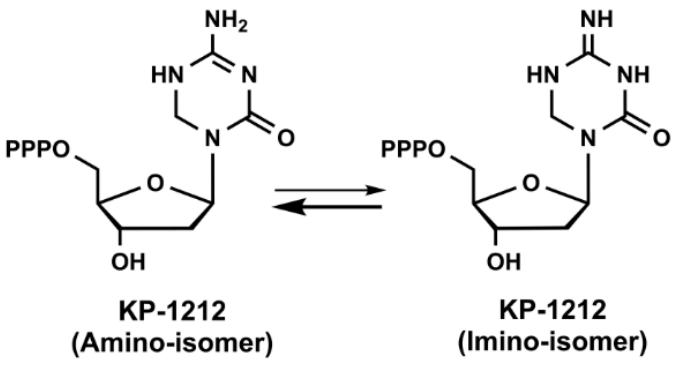
Figure 2. Chemical structures of KP-1212 in amino and imino